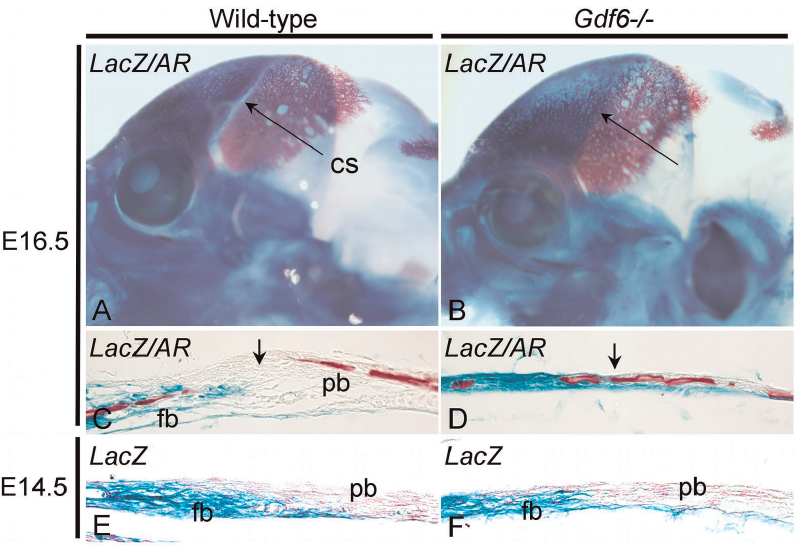
Figure 2. Analysis of boundary formation in Gdf6 2 / 2 embryos. E16.5 Wnt1Cre + / 2 ; R26R + / 2 ; Gdf6 + / + (A) and Wnt1Cre + / 2 ; R26R + / 2 ; Gdf6 2 / 2 (B) embryos were stained with Xgal to label the frontal bone followed by alizarin red to highlight the parietal bone. Sections through the lacZ / alzarin red stained embryos show the boundary between the labeled frontal bone and unlabeled parietal bone at the site of the wild-type suture (C, arrow), with bone continuing through the suture boundary in the Gdf6 2 / 2 embryo (D, arrow). E14.5 Wnt1Cre + / 2 ; R26R + / 2 ; Gdf6 + / + (E) and Wnt1Cre + / 2 ; R26R + / 2 ; Gdf6 2 / 2 (F) embryos were stained with Xgal and counterstained with nuclear fast red. In both the wild-type and Gdf6 2 / 2 coronal sutures, the boundary was distinct, with no evidence of cell mixing. AR, alizarin red; cs, coronal suture; fb, frontal bone; pb, parietal bone.